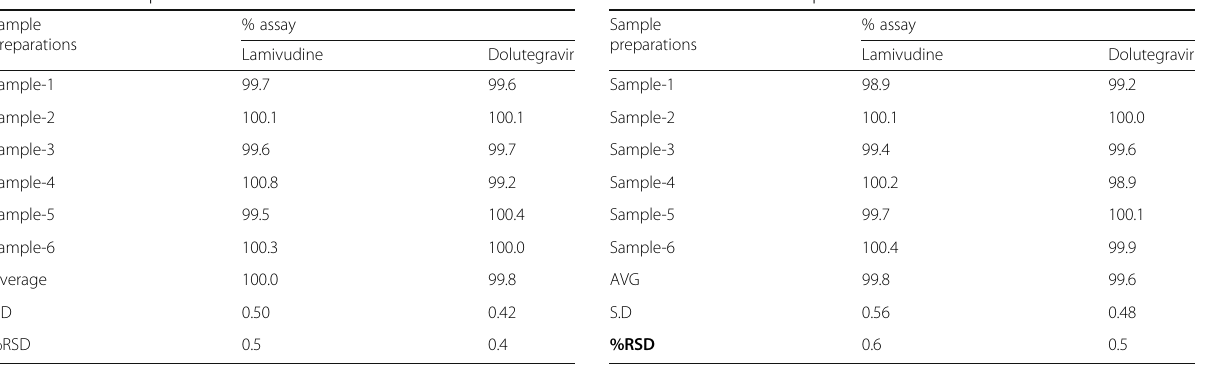
Table 7 Intermediate precision results